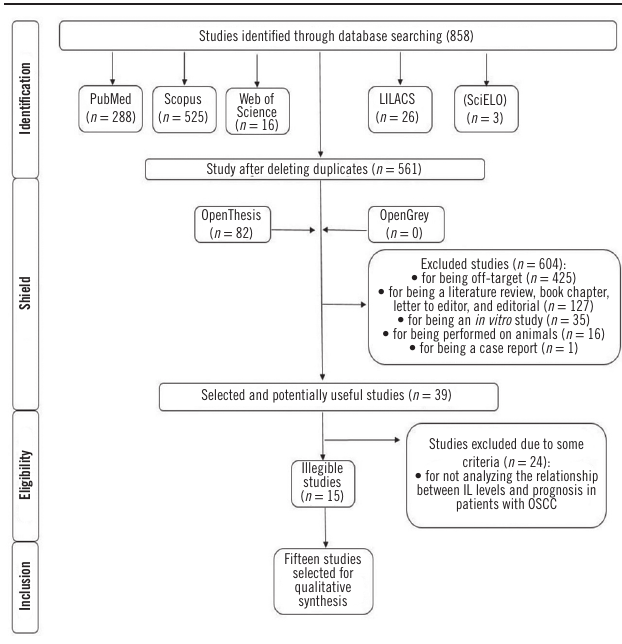
figurE − Flowchart that defines the search strategy result IL: interleukins; OSCC: oral squamous cell